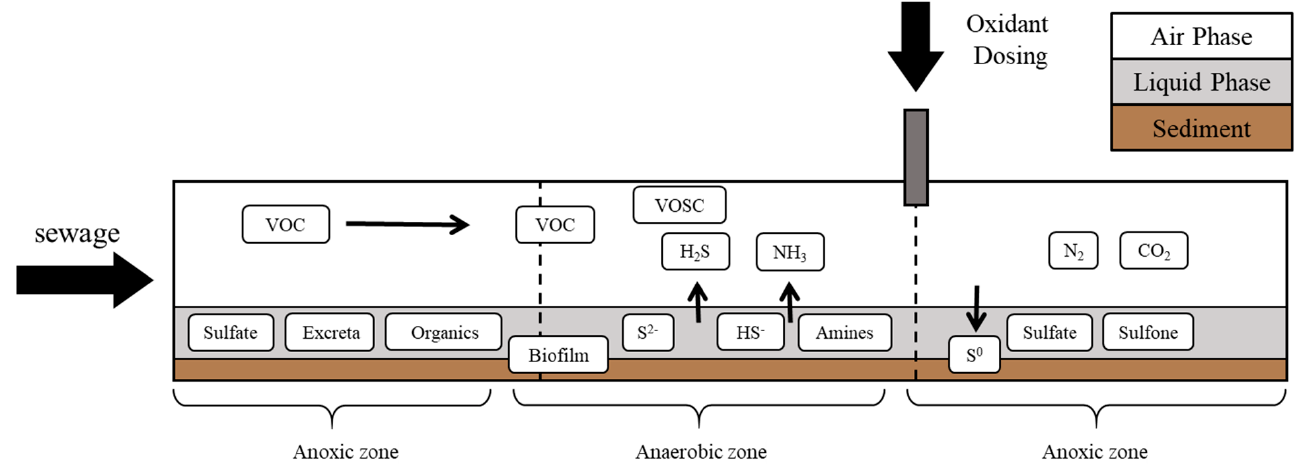
Figure 3. Schematic of strong oxidant dosing.